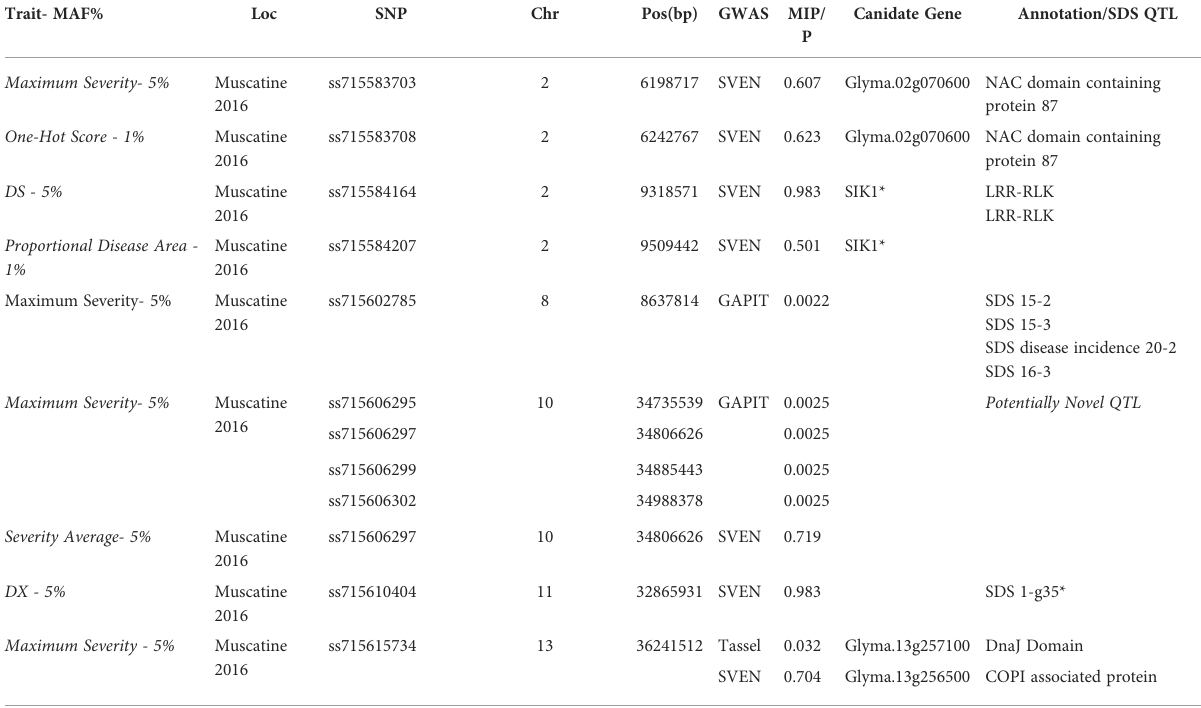
TABLE 6 Description of subset of signi fi cant SNPs and associated candidate genes. Trait-